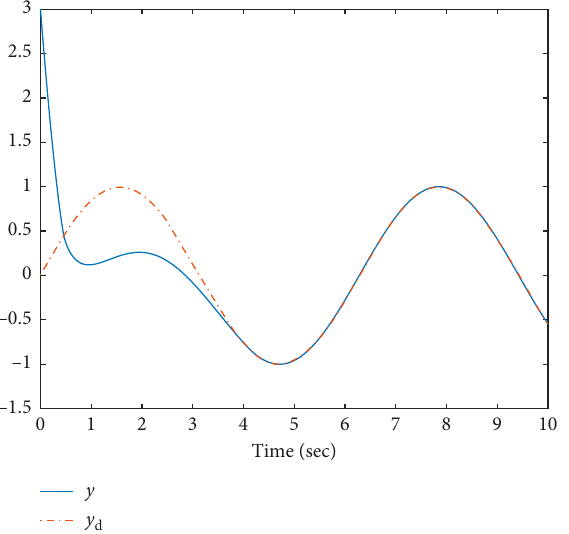
Figure 13: Finite-time convergence of the output and reference signal in control.